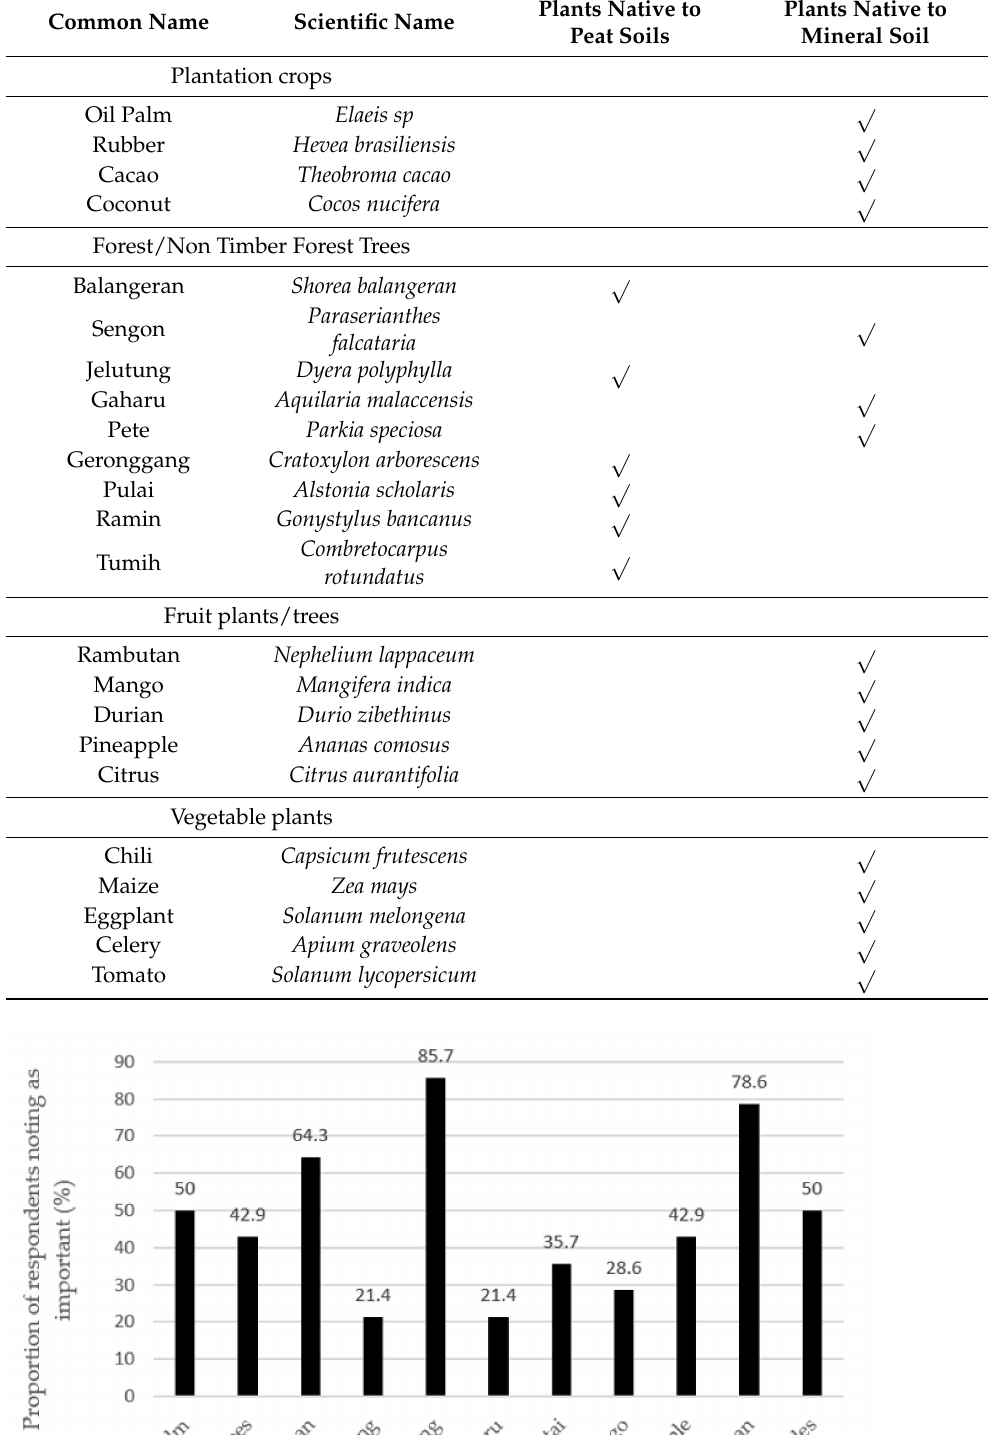
Table 2. Summary of home yard plant species considered by the respondents to be important.